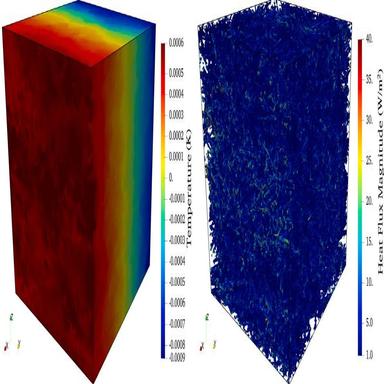
Temperature (left) and flux (right) fields for FiberFormTM sample A for a conductivity simulation in the direction.